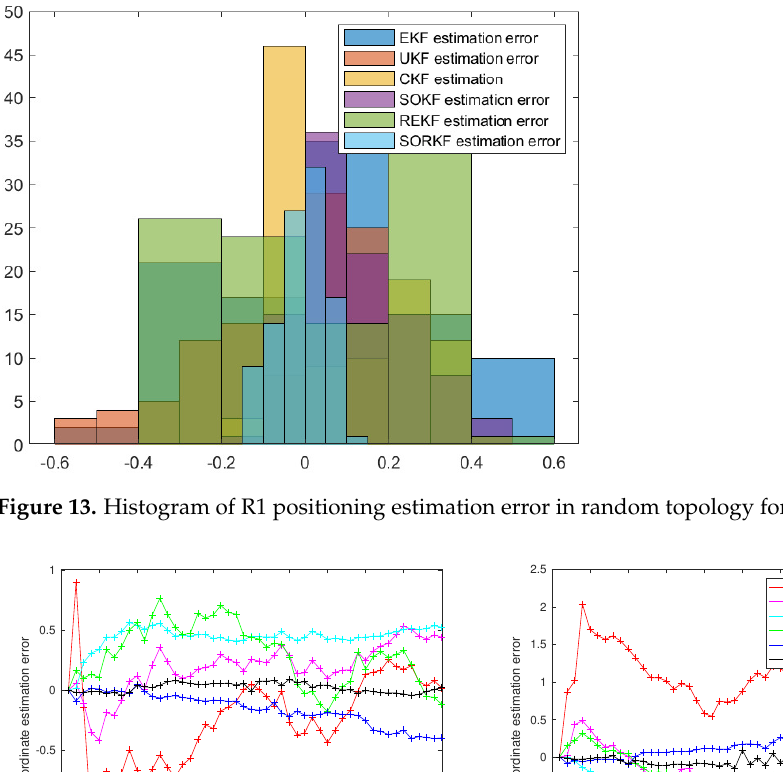
Figure 12. R1 estimation error of multi-robot swarm in random topology formation. ( a ) X-Coordinate estimation error; ( b ) Y-Coordinate estimation error.